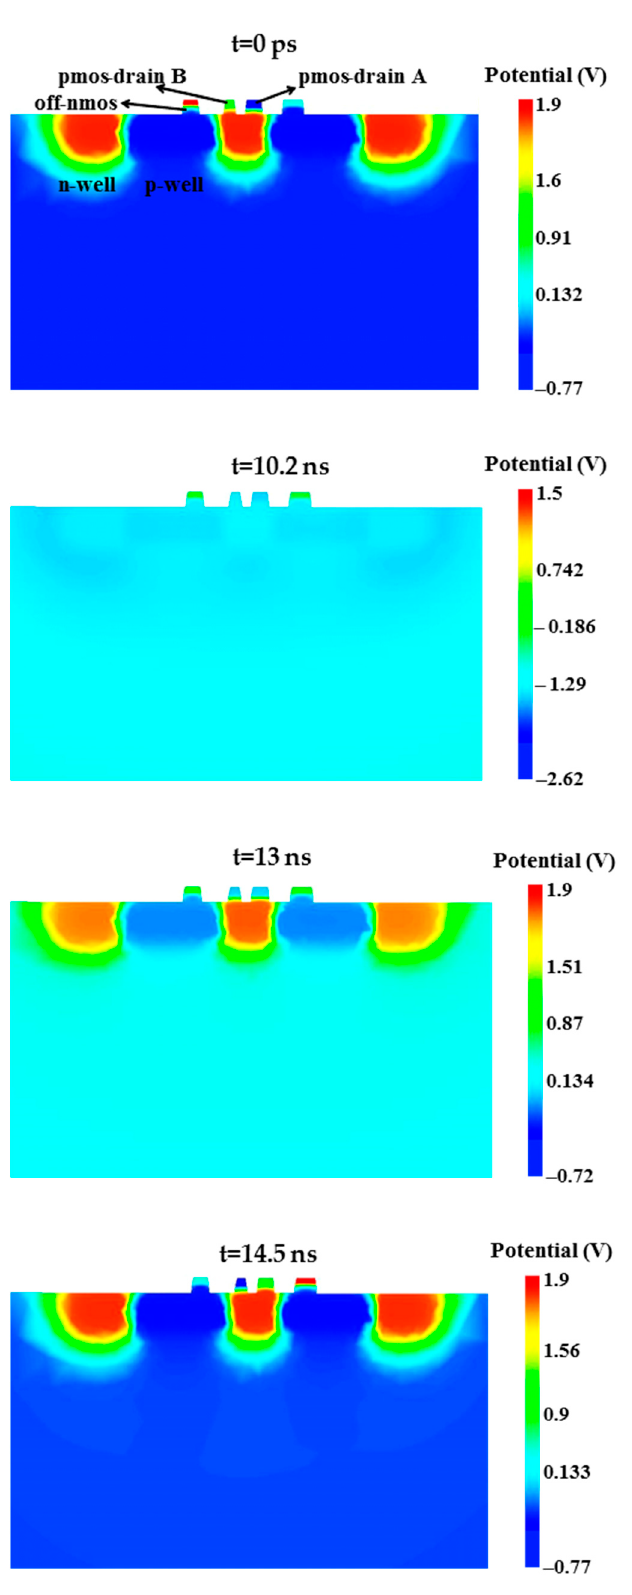
Figure 6. The potential evolution for the case of SESD in the PSS direction.